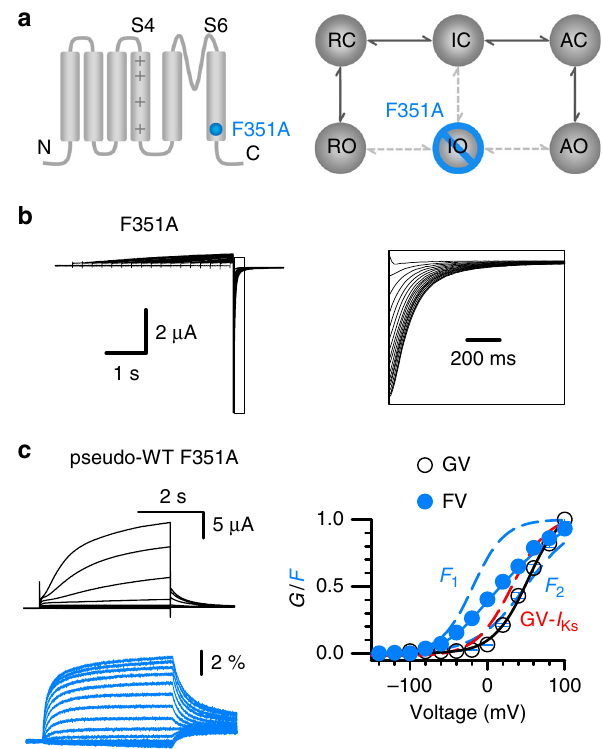
Fig. 3 F351A suppresses the IO state and eliminates hook currents. a Schemes to illustrate the location of the mutation in the KCNQ1 subunit (left) and show that the IO state was suppressed by F351A mutation (right). b Representative hook currents of F351A recorded in 100 mM K + solution. The pre-pulses were +40 mV, with 0.02 – 4 s time durations, and the test pulse was 2 s long at − 120 mV. The right panel shows tail currents with an expanded time scale. c VCF recordings of F351A currents (black) and fl orescence (blue). Right panel shows the G – V (open circle) and F – V (solid circle) relationships of F351A with the F 1 and F 2 components (dotted blue lines). The red dotted line is the G – V relationship of I Ks channels. n ≥ 4. Error bars are the